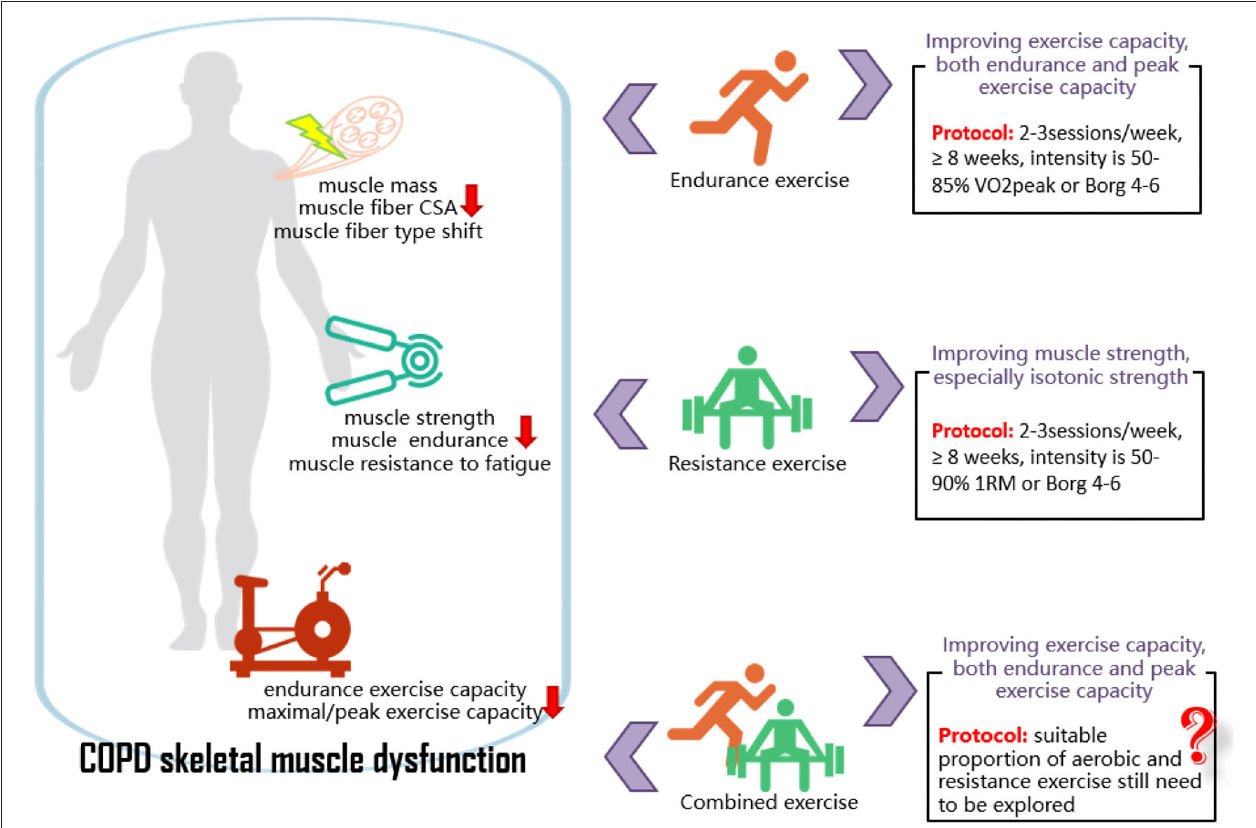
FIGURE 6 | COPD skeletal muscle dysfunction and the effects of exercise on it. COPD, chronic obstructive pulmonary disease; CSA, cross-sectional area; RM, repetition maximum; VO 2peak , peak oxygen